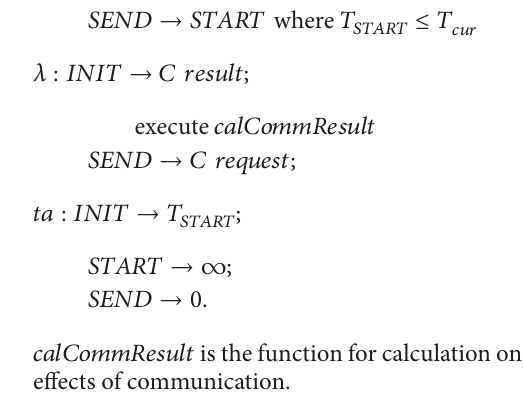
In this way, the influence of the network model affects the generating different types of